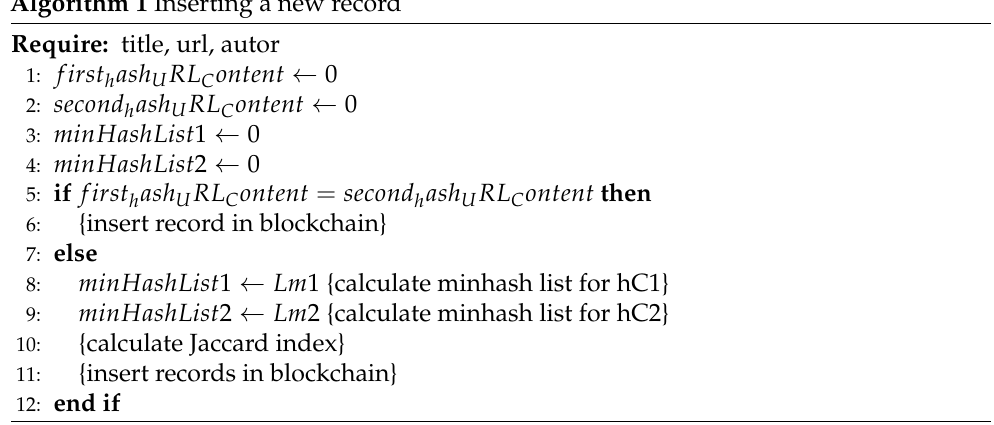
Algorithm 1 Inserting a new